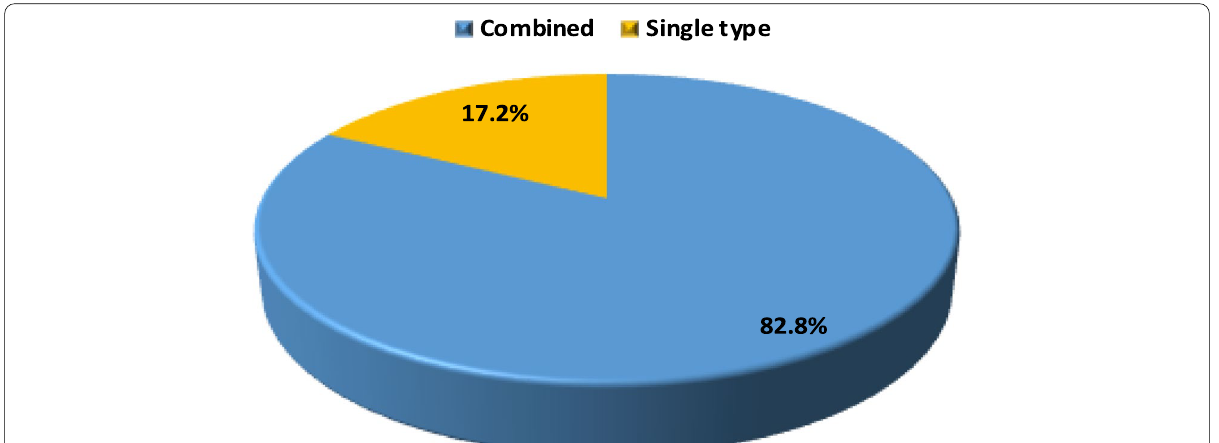
Fig. 1 Distribution of combined and single types of apraxia in the group of cases. 82.8% of patients had combined apraxia while 17.2% had a single type of apraxia